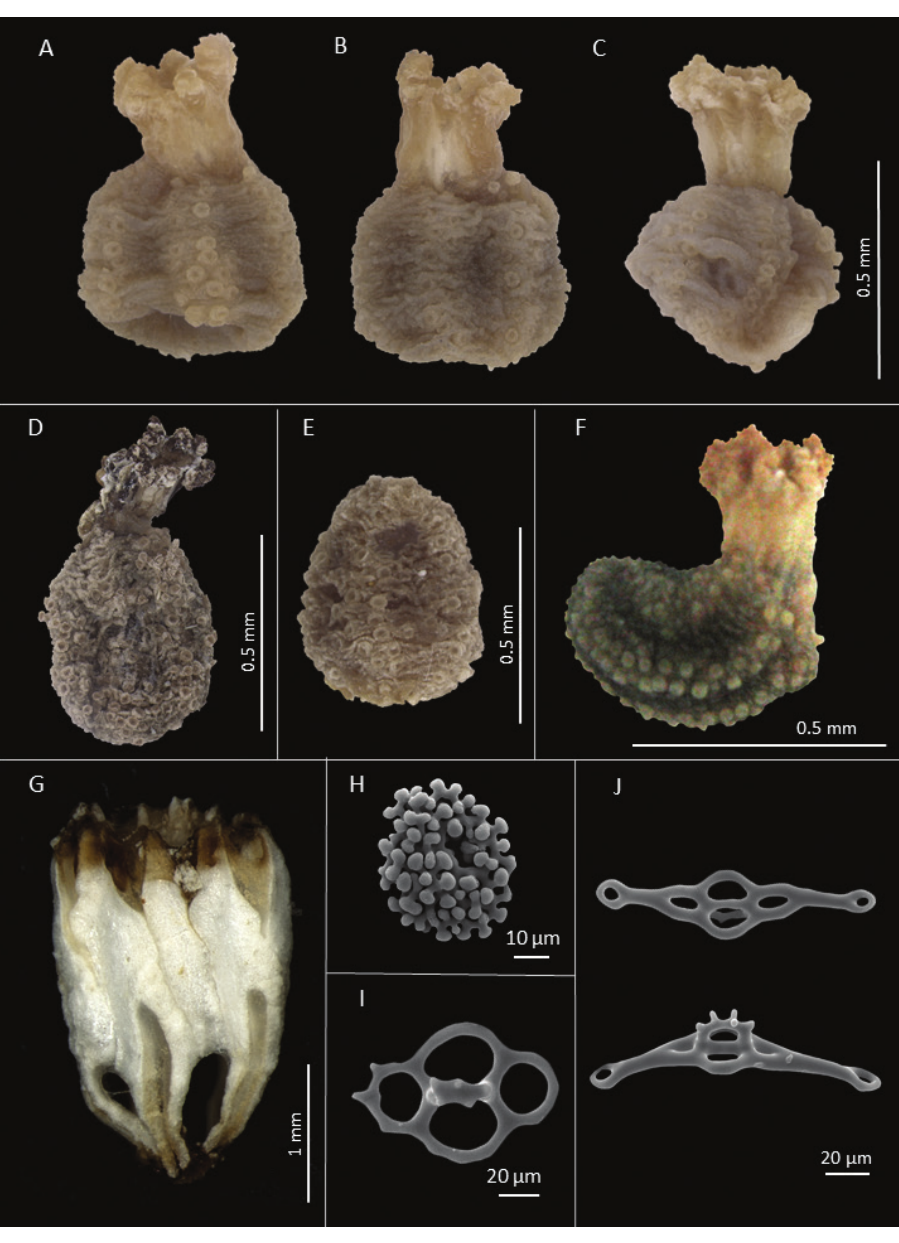
Figure 1. Pentamera paraibanensis sp. n. External view of holotype, A Dorsal B Ventral C Lateral D Ex- ternal view of specimen UFPB.ECH-2048, E External view of specimen UFPB.ECH-2058 F External view of specimen UFPB.ECH-2089. G Calcareous ring H Rosette of tentacles I Table from body wall J Support tables from tube